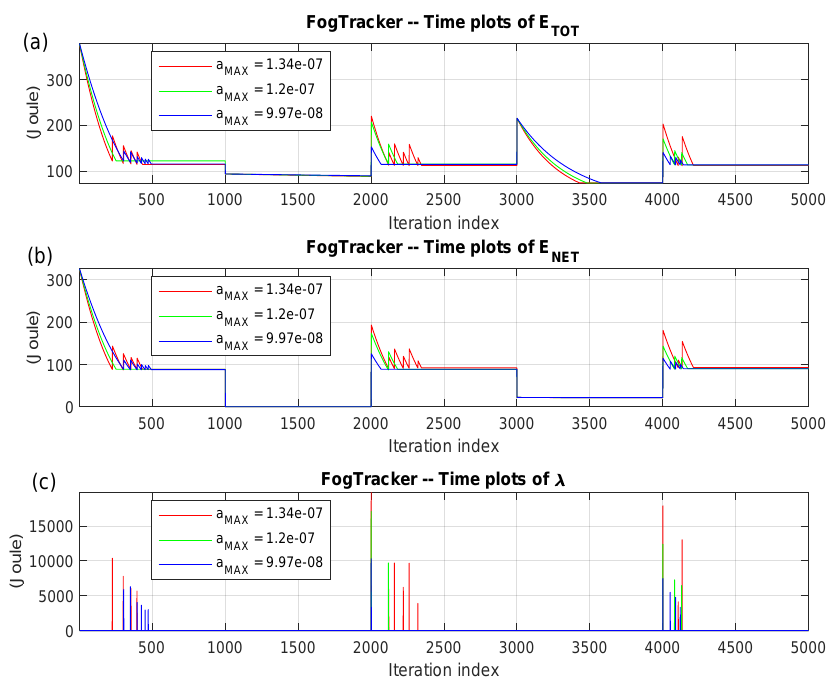
Figure 8. Tracking performance under DAG2 for three values of the speed-factor a MAX . ( a ) time behaviors of the total energy E TOT ; ( b ) time behaviors of the corresponding network energy E NET ; and ( c ) time behaviors of the λ multiplier.